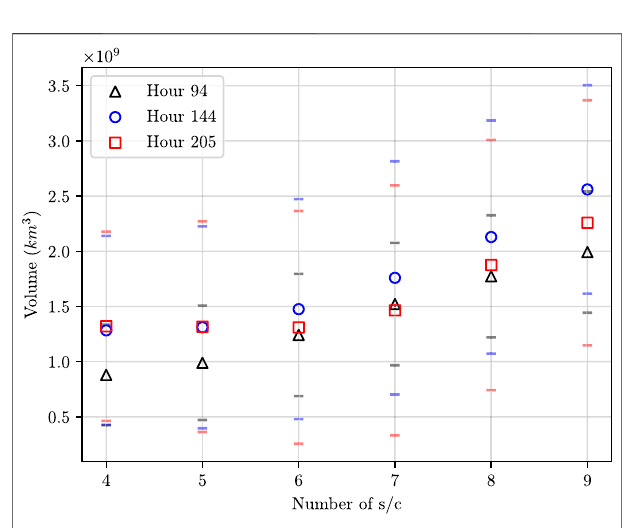
FIGURE12| Meanvaluesofvolumewhichwerereconstructed withless than 5% error for the three nine-spacecraft con fi gurations analyzed. The dashesabove/belowthemarkersrepresentonestandarddeviationawayfrom the mean volume for each con fi guration.